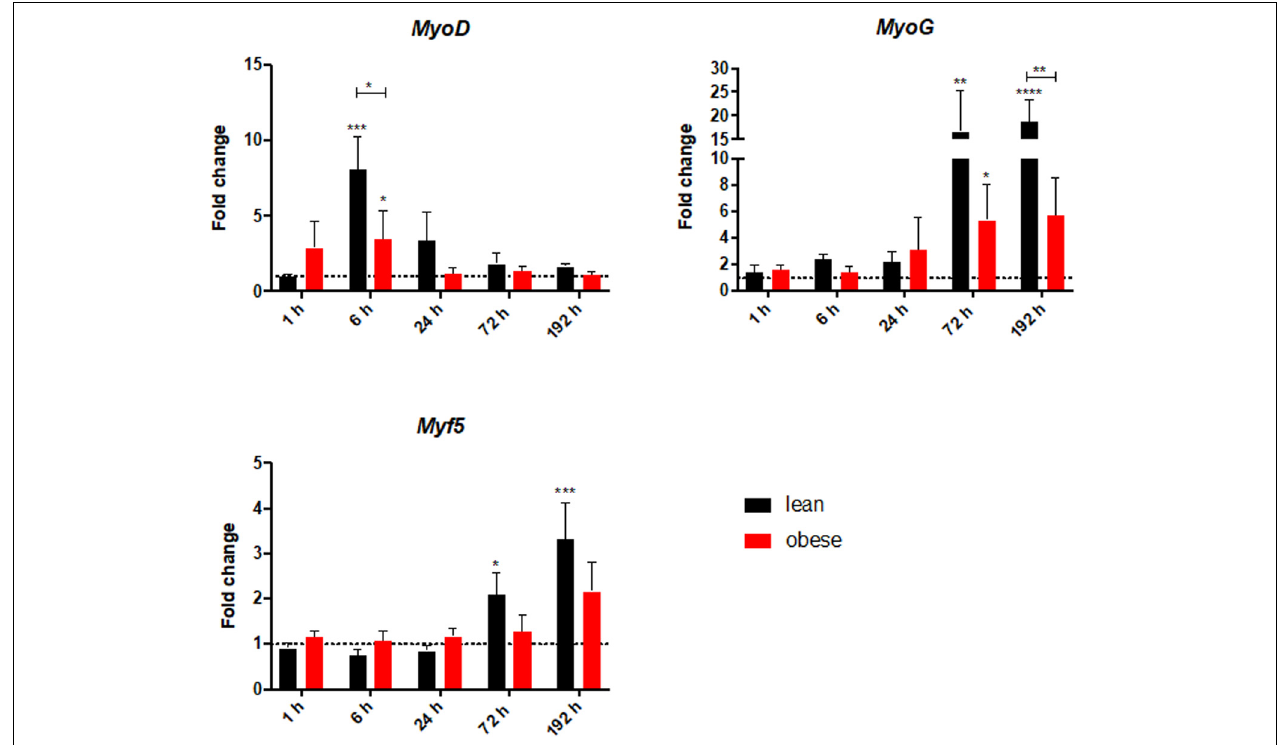
FIGURE 8 | Decreased level of satellite cell activation in obese mice based on gene expression profile of satellite cell genes MyoD , MyoG, and Myf5 . These levels were determined in injured muscle of lean and obese control and trauma animals. Statistical significance was determined using two-way ANOVA followed by an uncorrected Fisher’s LSD test ( α = 0.05). * p < 0.05, ** p < 0.01, *** p < 0.001, **** p < 0.0001. Indicators of significance directly above the bars of the diagram indicate a statistical difference to the control, while starts above the connector line show differences between the two diets at that specific time